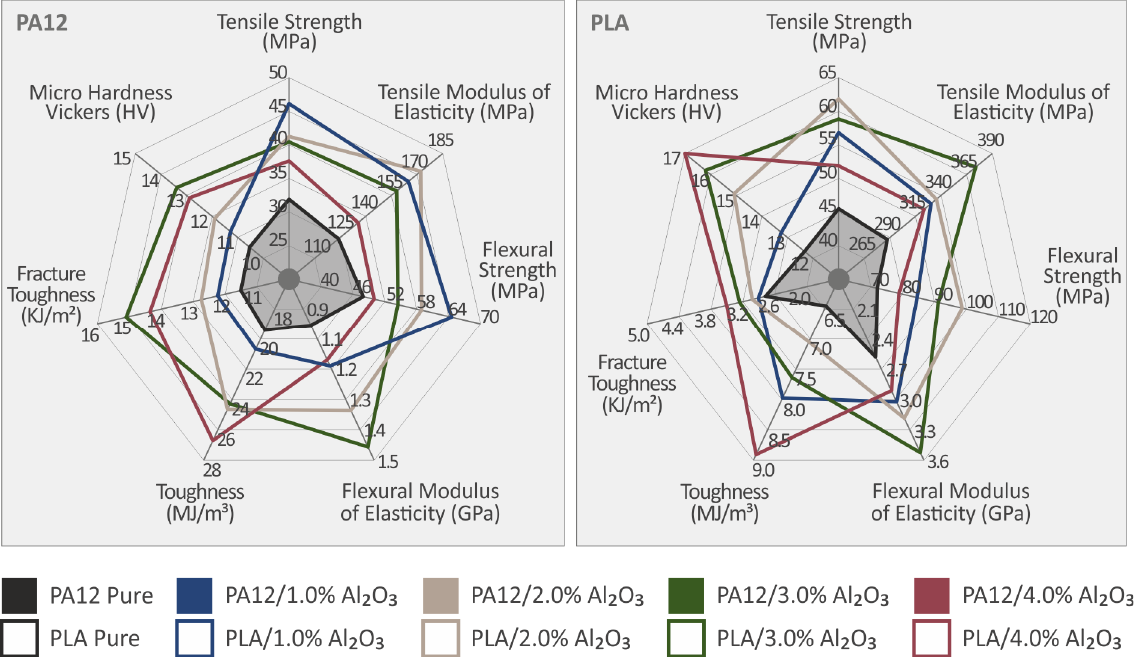
Figure 18. Spider graph summarizing the experimentally determined mechanical properties of pure PA12 and PLA compared to PA12/Al 2 O 3 and PLA/Al 2 O 3 3DP nanocomposites at 1.0, 2.0, 3.0, and 4.0 wt.% of Al 2 O 3 filler loading. The shaded area presents the mechanical response of the pure materials. Legend shows which color corresponds to which material in each graph.